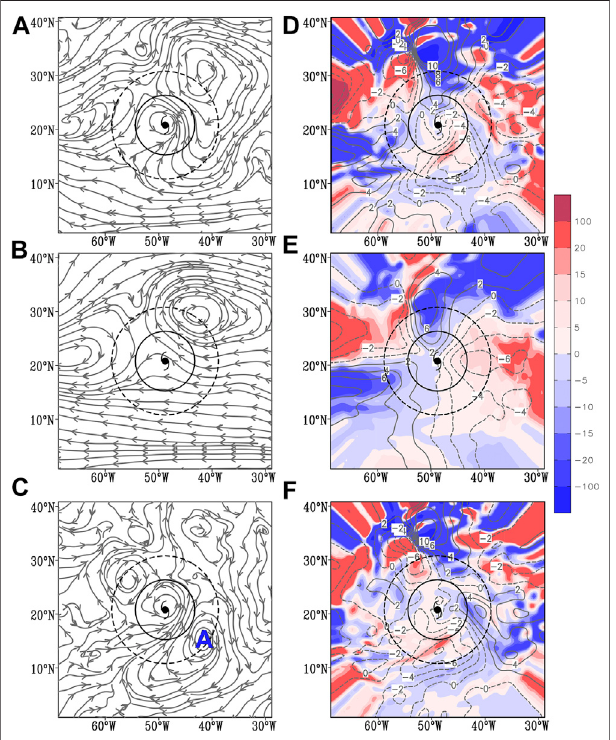
FIGURE 9 | As in Figure 7 but for 600 hPa.